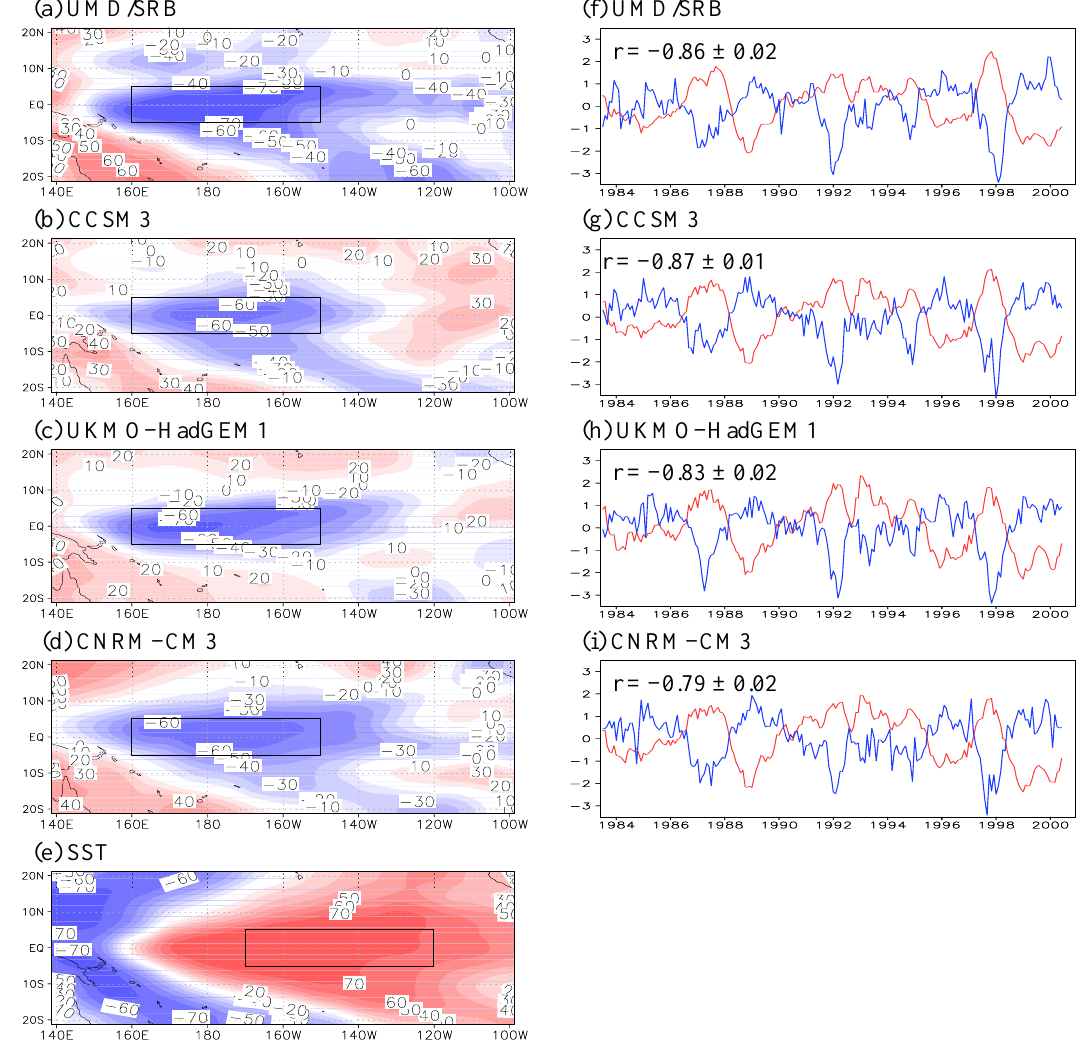
Fig. 4. Canonical correlation patterns in (%) by regressing the canonical correlation coefficients (CCC) with SW ↓ surf data for: (a) UMD/SRB; (b) CCSM3; (c) UKMO-HadGEM1; (d) CNRM-CM3; and (e) SST. The SST pattern corresponds to the analysis between UMD/SRB and SST. The boxes stand out for the connected areas. Canonical correlation coefficients of SW ↓ surf (blue line) and SST (red line) for: (f) UMD/SRB; (g) CCSM3; (h) UKMO-HadGEM1; (i)